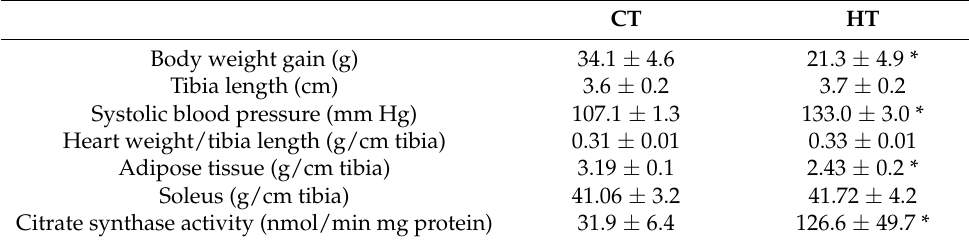
Table 1. Animal evolution.